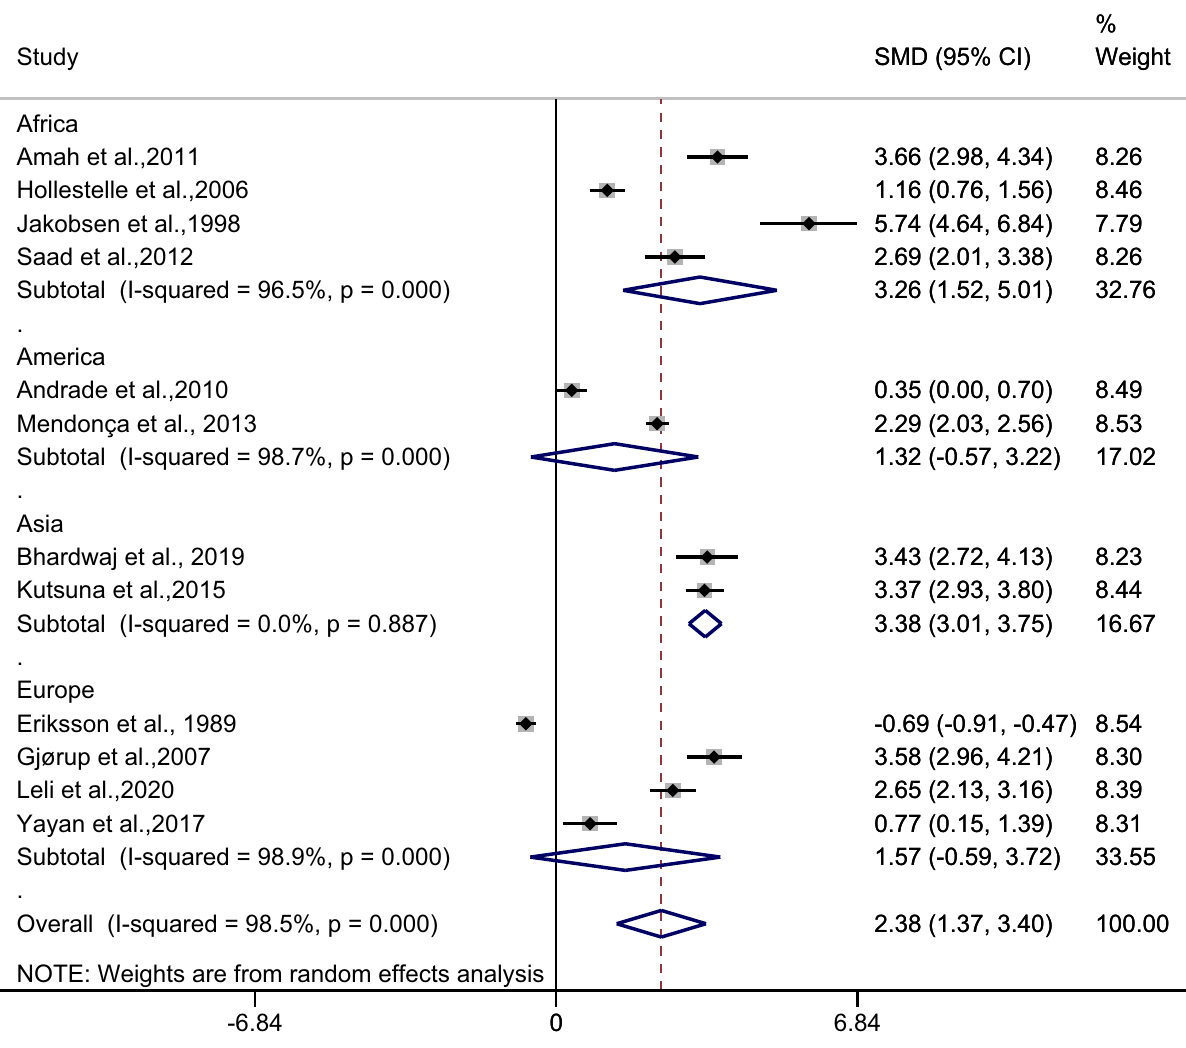
Figure 7. Forest plot demonstrates the difference in the mean CRP level between patients with uncomplicated malaria and healthy/febrile controls by continents. SMD, standard mean difference; CI, confidence